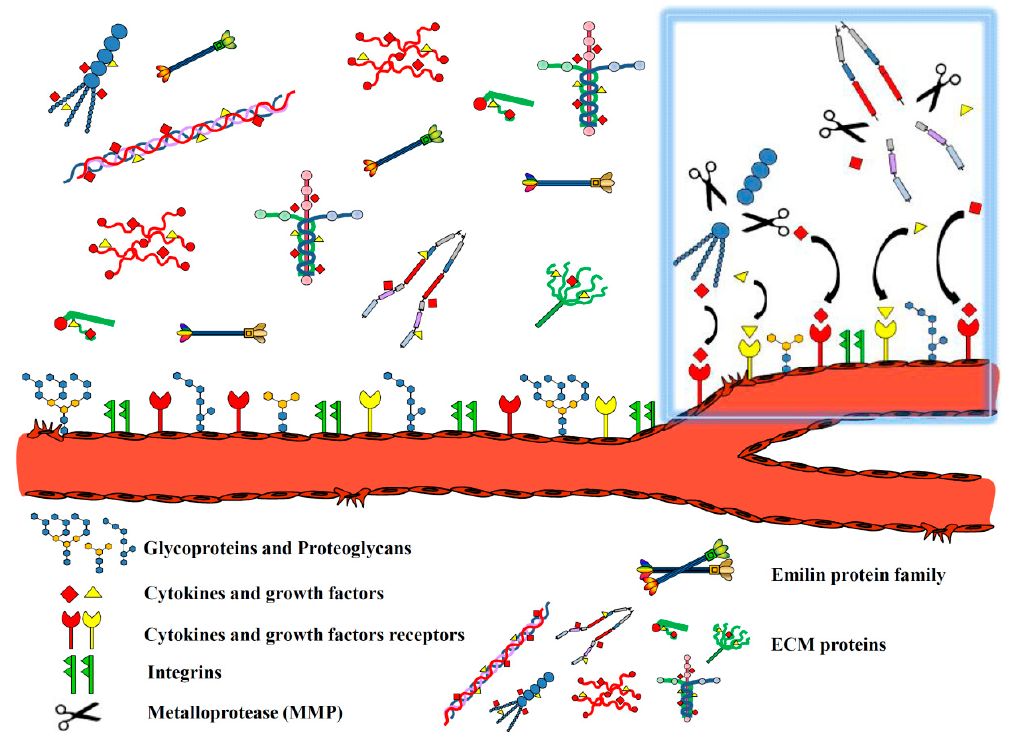
Figure 1. Schematic representation of key extracellular matrix (ECM) components involved in angiogenesis. On the left the major classes of ECM proteins that exert a role in angiogenesis are reported. The mechanism of growth factor release from ECM molecules through the action of proteases, activated upon angiogenic stimulus, is highlighted within the baby blue rectangle.